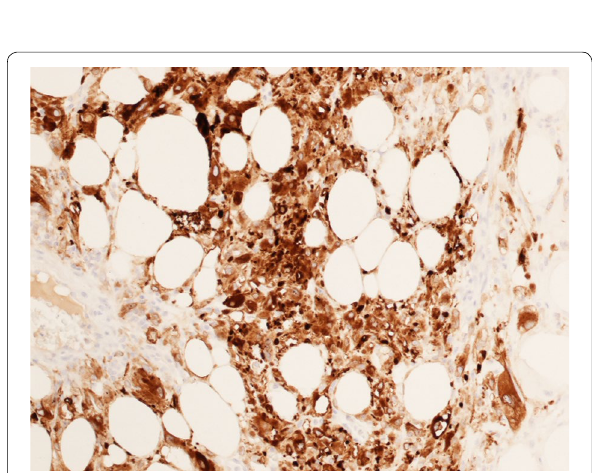
Fig. 4 Melan-A positive spindle and epithelioid cells (